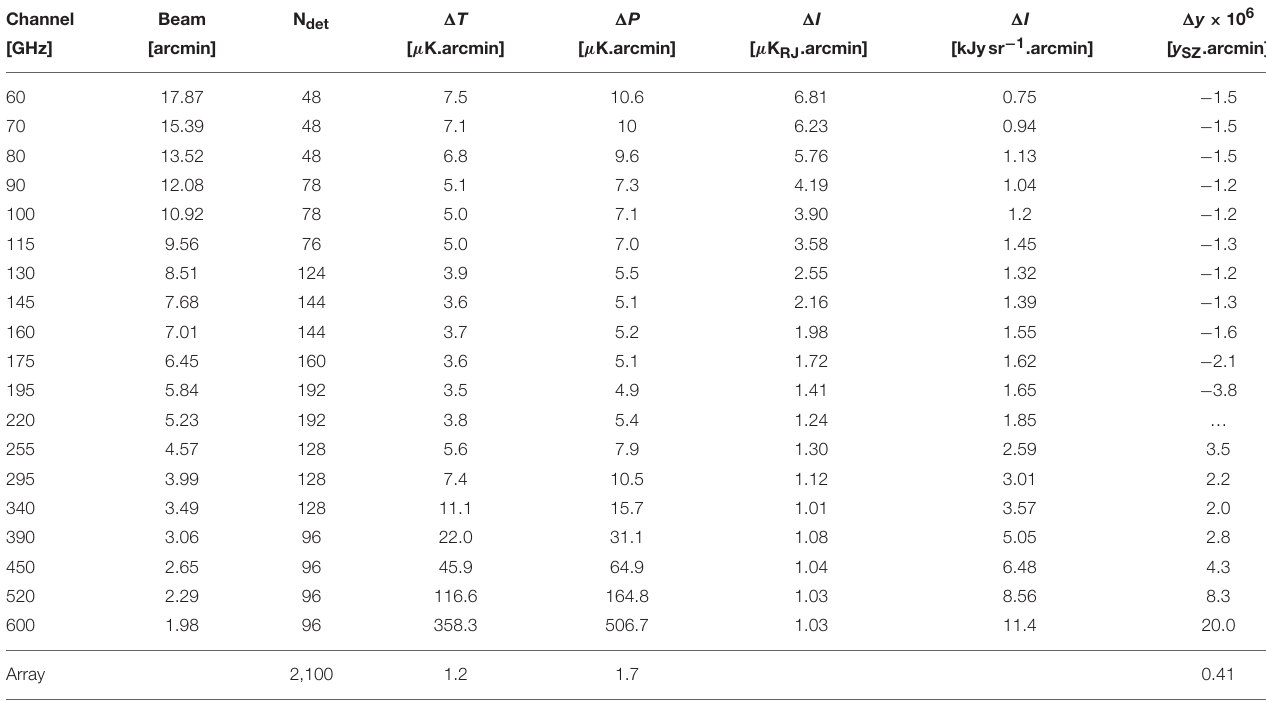
TABLE 1 | Proposed CORE-M5 frequency channels and performance.